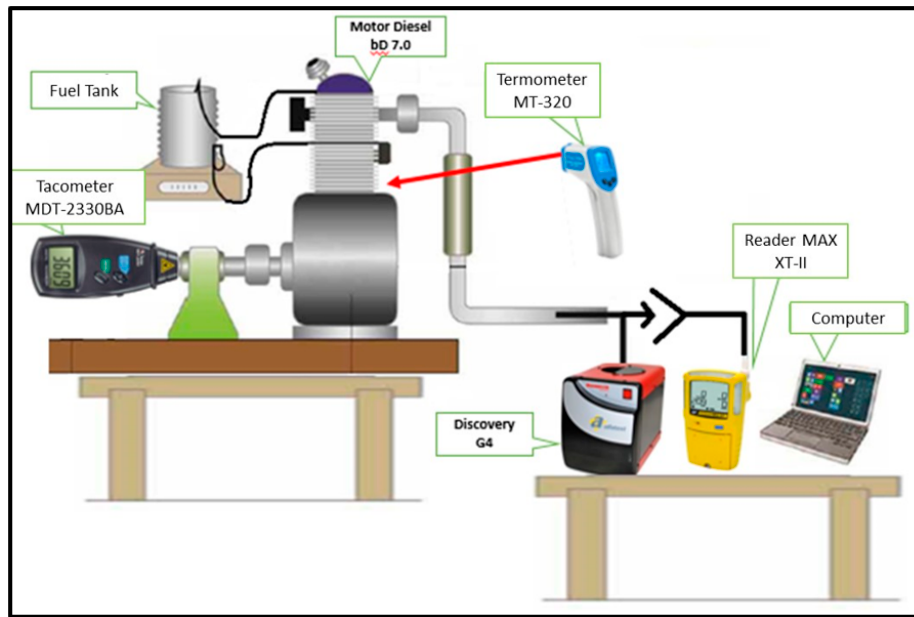
Figure 2. Test bench and instrumentation.